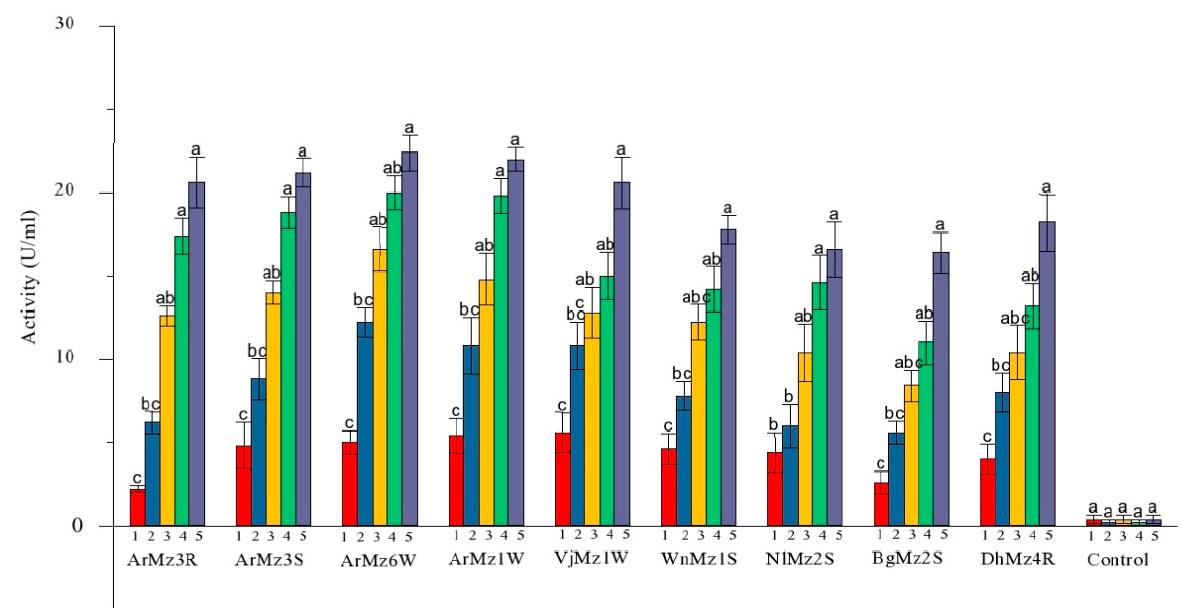
Figure 3. Activities of the proteases (U/mL), Mean ± SE in the liquid culture media of the entomopathogenic fungi in the presence of H. puera cuticle. Statistical differences are shown by different letters (Tukey’s test, p < 0.001). Each color indicating different days of incubation (1st to 5th days).